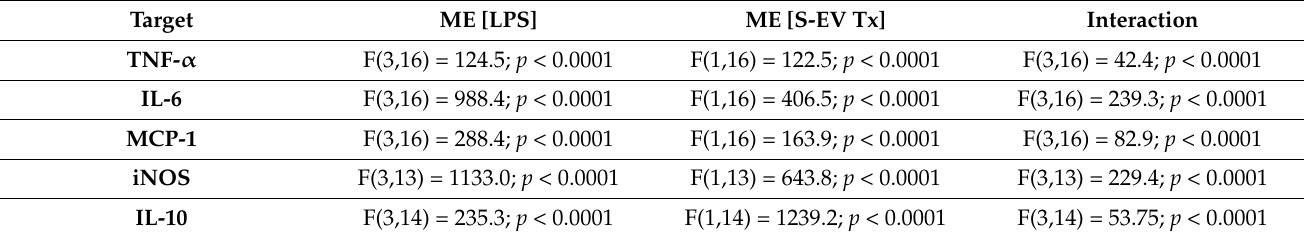
Table 3. Statistics for Figure 4.